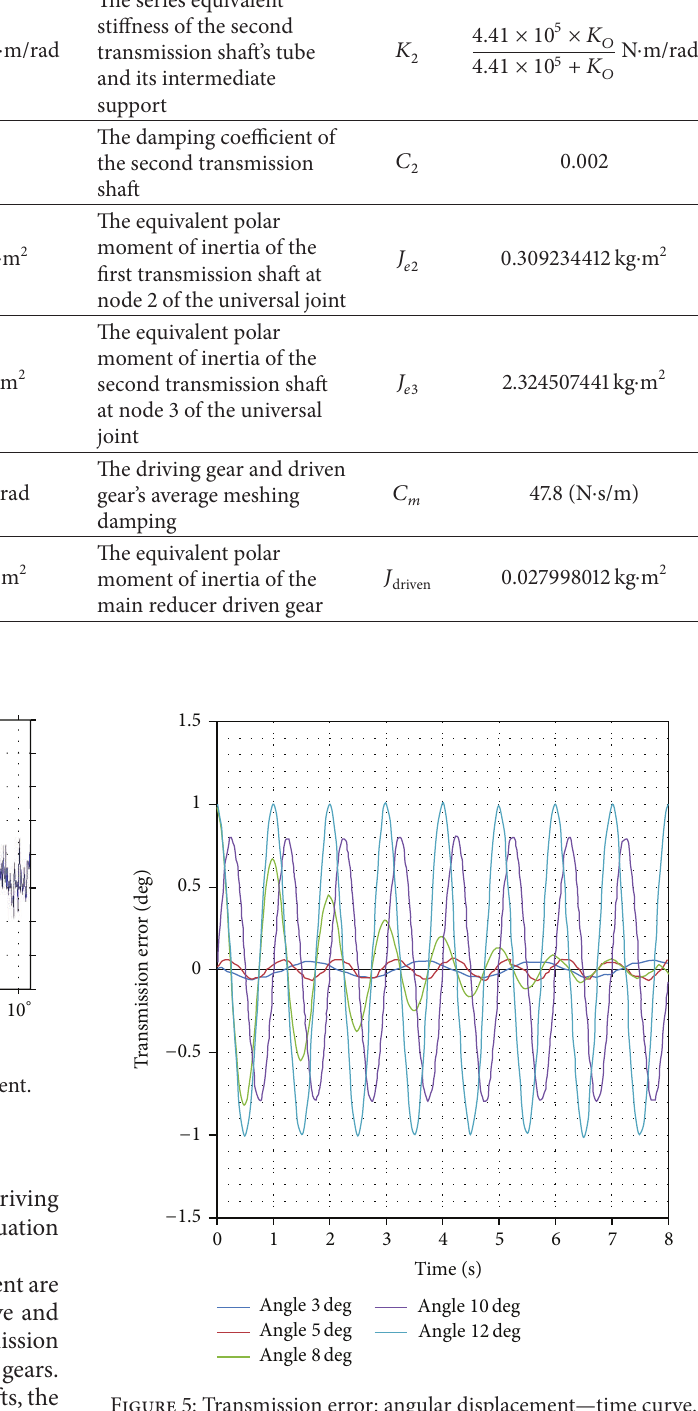
the transmission error fluctuates cyclically. Different angles between transmission shafts lead to different transmission accuracies. When the angle between